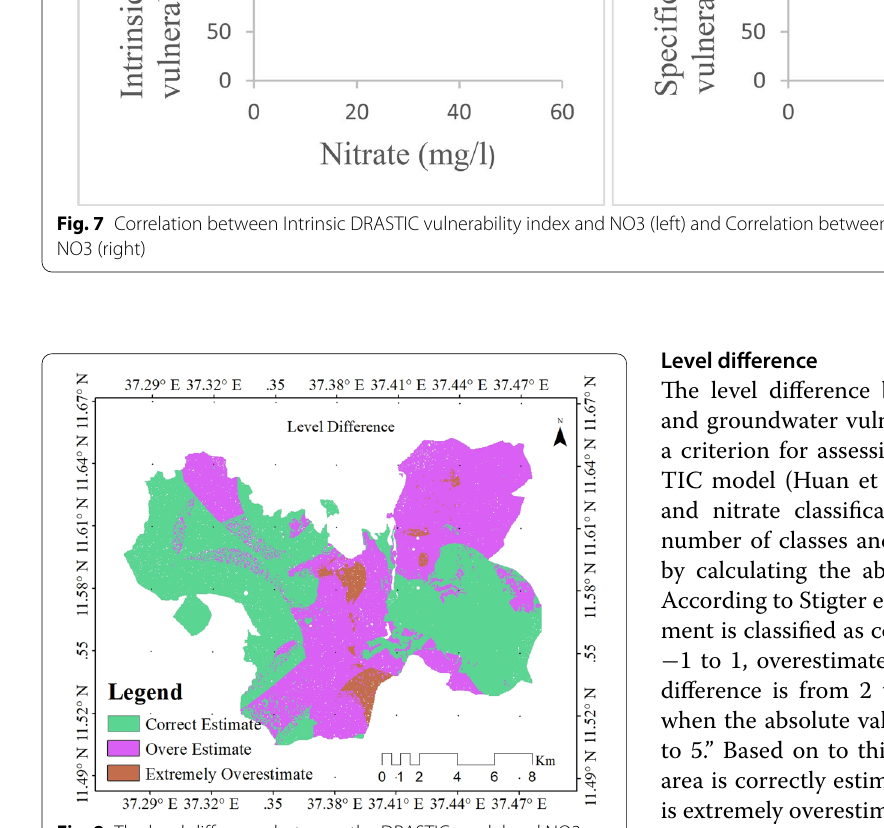
Fig. 8 The level difference between the DRASTIC model and NO3